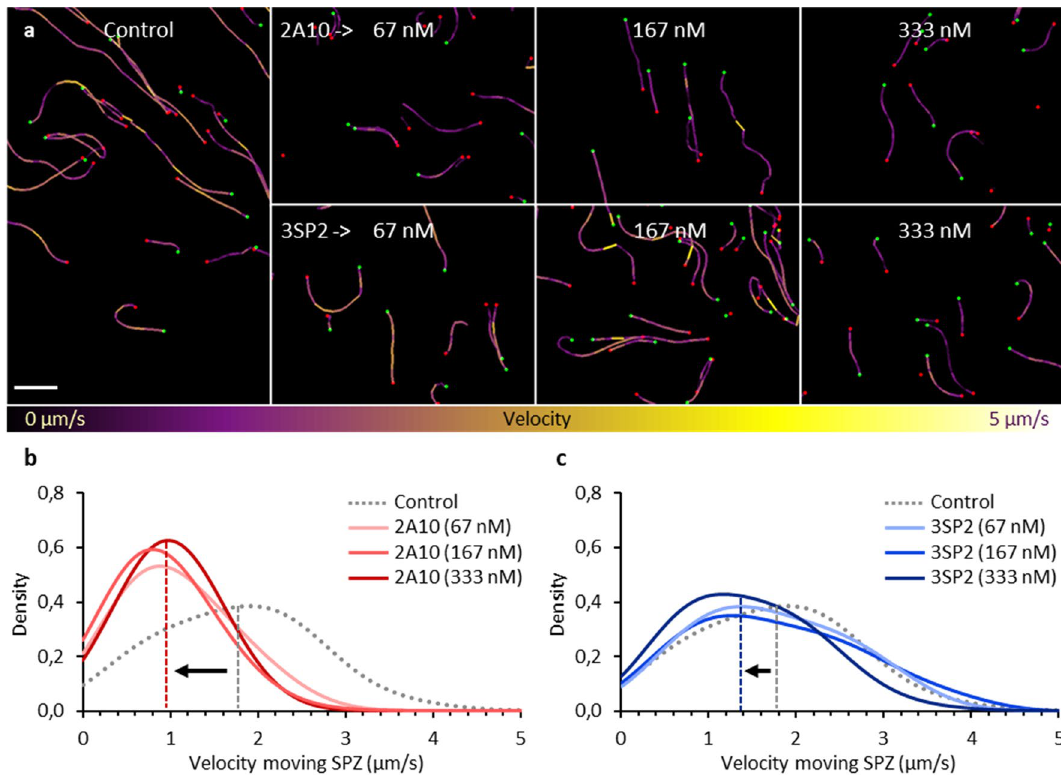
Figure 4. SPZ velocity in human skin explant ( a ) Tracks of SPZ moving in human skin explant, color-coded for velocity using colour range: purple (low velocity) to yellow (high velocity). Scalebar: 100 µm. ( b ) The probability distribution plotted of the velocity of control SPZ (median: 1.8 (IQR: 1.1–2.3) μm/s, median annotated with grey dashed line) and SPZ exposed to increasing concentrations (67, 167, 333 nM) of 2A10 (median velocity SPZ exposed to 333 nM: 1.0 (IQR: 0.7–1.3) μm/s, median annotated with red dashed line). ( c ) The probability distribution plotted of the velocity of control SPZ and SPZ exposed to increasing concentrations (67, 167, 333 nM) of 3SP2 (median velocity SPZ exposed to 333 nM: 1.4 (IQR: 0.8–2.0) μm/s, median annotated with blue dashed